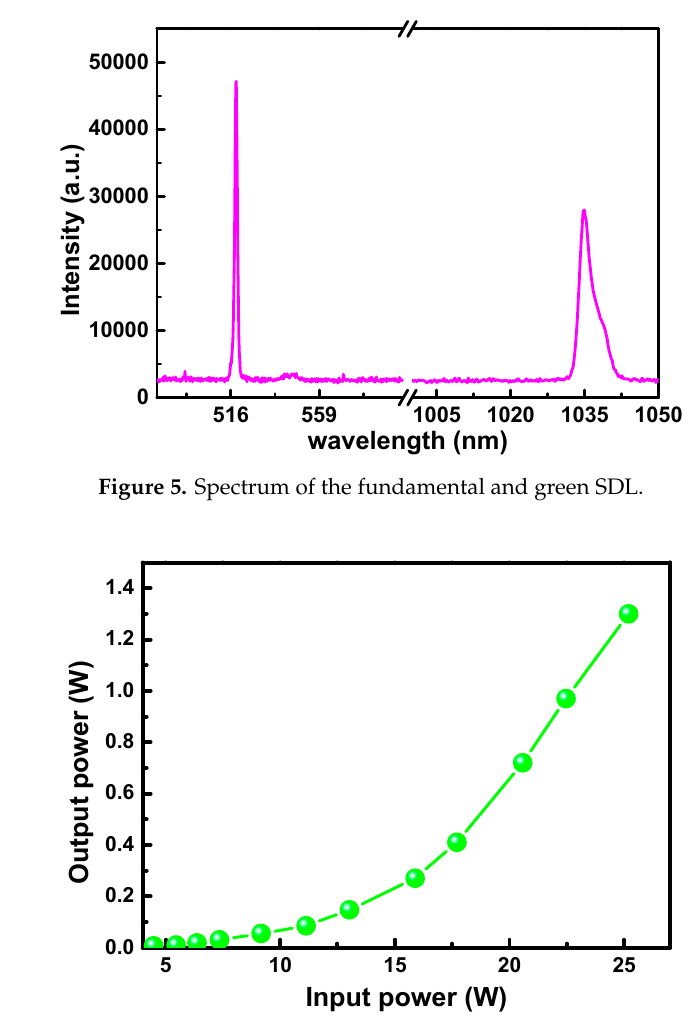
Figure 6. Output powers of the green SDL.